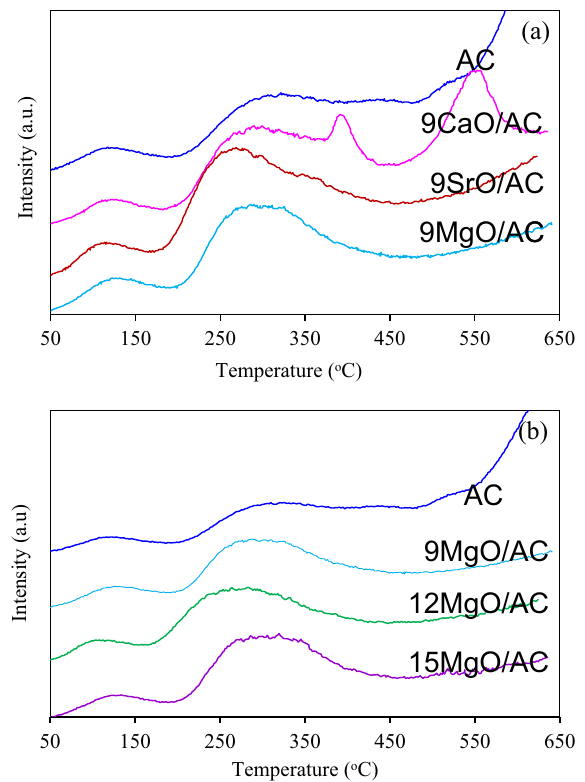
Figure 7. CO 2 -TPD of ( a ) 9MO/AC and ( b ) x MgO/AC